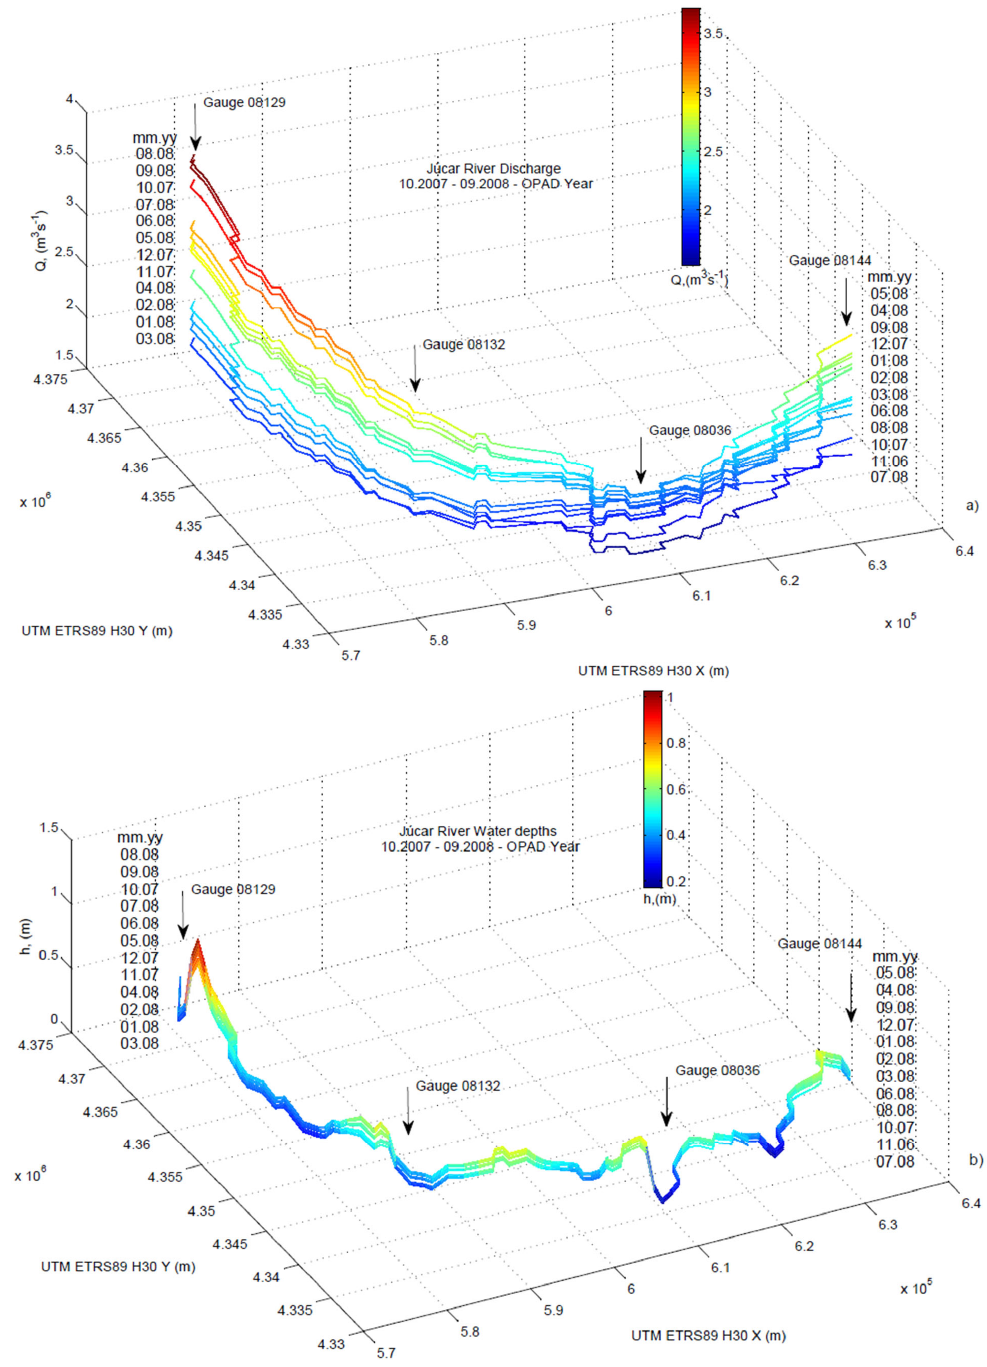
Figure 7. As an example, monthly mean values of discharge Q ( a ) and depths h ( b ) are represented with a spatial distribution of 1000 m for hydrologic year 10.2007–09.2008 when OPAD measures were